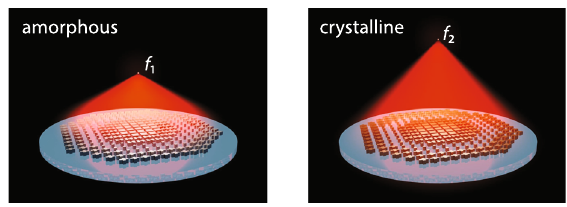
Fig. 1 Artistic rendering of a recon fi gurable varifocal metalens. Incident light is focused on the fi rst focal plane ( f 1 = 1.5 mm) when the meta-atoms are in the amorphous state and the second focal plane ( f 2 = 2.0 mm) in the crystalline